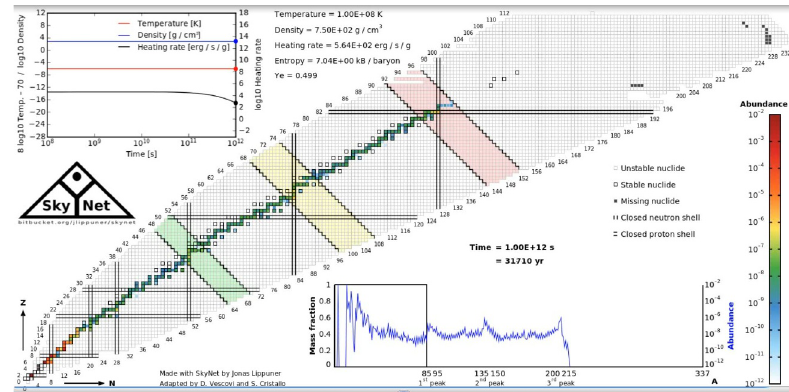
Figure 1. Typical pattern of the s-process. The plot has been produced with the PYTHON graphical interface of the SKYNET code